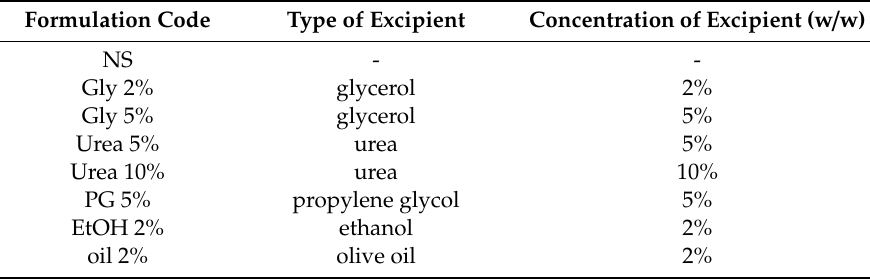
Table 1. Overview of formulations produced in this